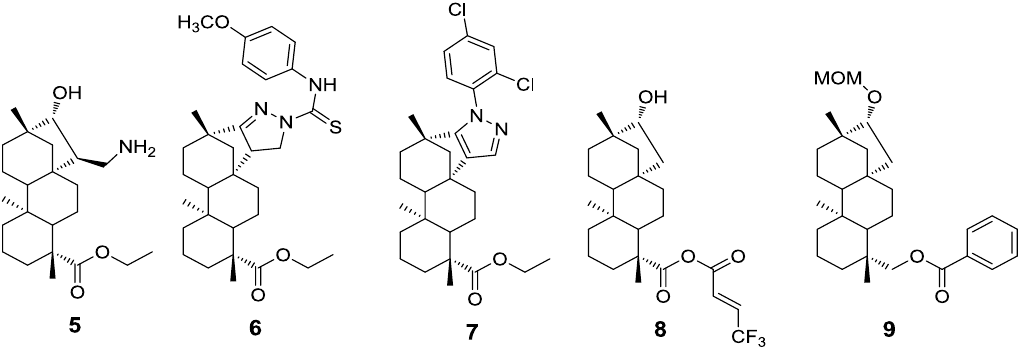
Figure 2. Isosteviol derivatives exerted anti-cancer